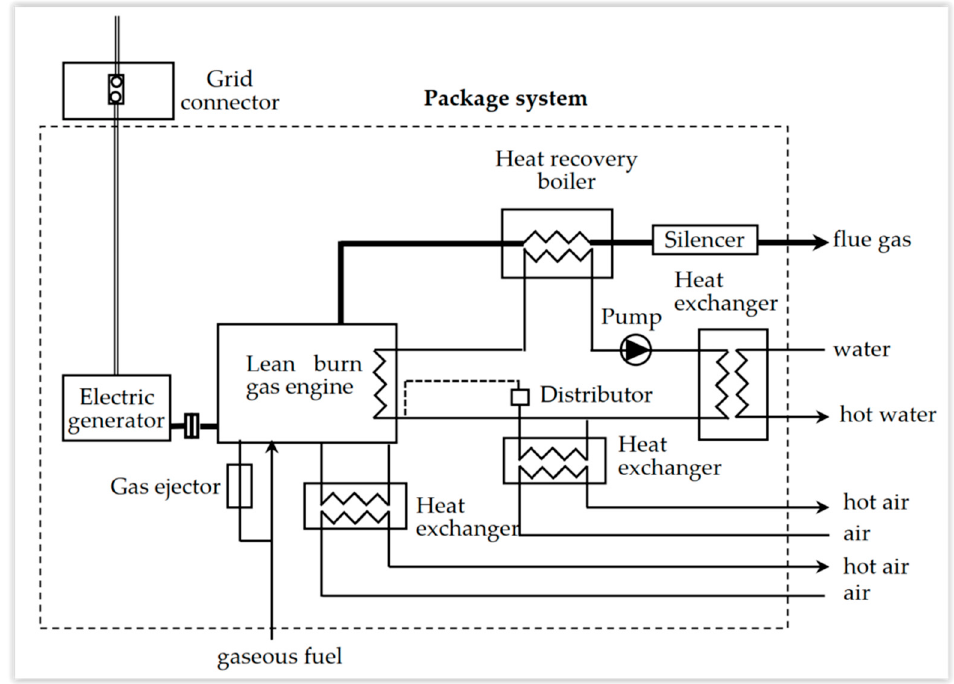
Figure 3. Schematic diagram of a gas engine cogeneration unit [16].